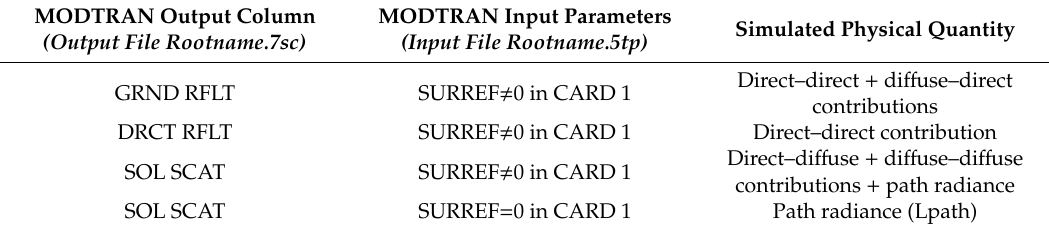
Table 1. MODTRAN outputs used in the